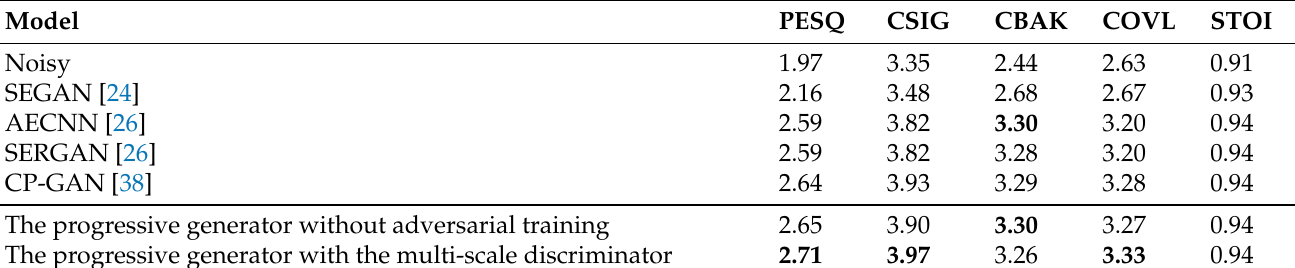
Figure 6. Illustration of L 1 ( G n ) as a function of training steps. Table 4. Comparison of results between different GAN-based speech enhancement Techniques. The best result is highlighted in bold